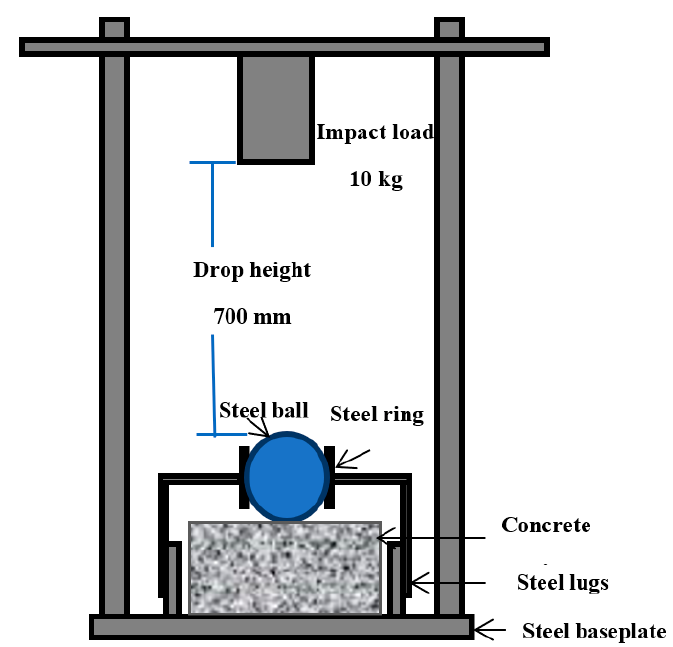
Figure 2. Details of the repeated drop mass impact (RDMI)_ testing